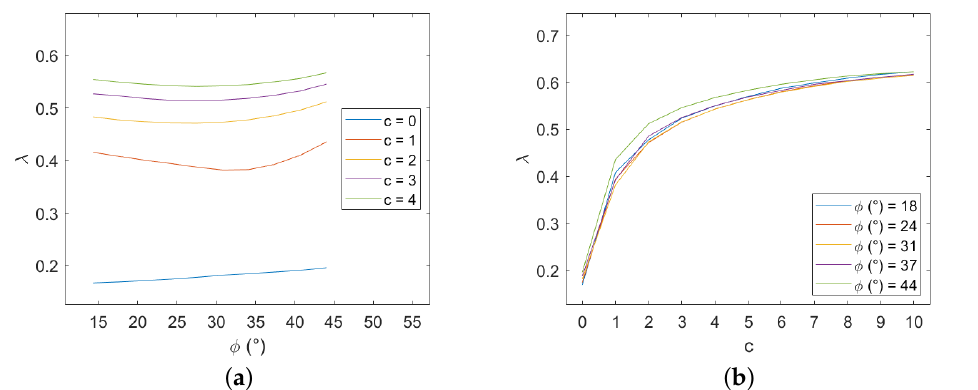
Figure 18. Periodic masonry, failure multiplier for different values of cohesion c and internal friction angle ϕ of the blocks: ( a ) effect of variation of ϕ for different values of c , ( b ) effect of variation of c for different values of ϕ